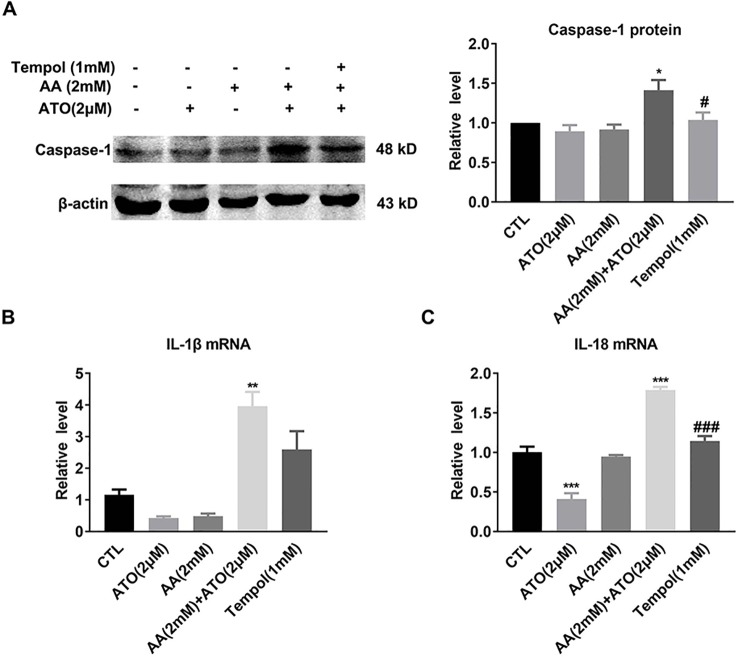
Antagonistic effects of tempol on the pro-pyroptotic action of ATO (2 μM)/AA (2 mM) combination in SW620 cells. (A) Tempol (1 mM) abolishes the elevation of caspase-1 protein level induced by ATO (2 μM)/AA (2 mM) combination treatment. The data are represented as mean ± SEM (n = 5). *P < 0.05, vs. Ctl; #
P < 0.05 vs. AA + ATO. (B, C) Tempol (1 mM) mitigated the increased mRNA levels of IL-1β and IL-18 induced by ATO/AA combination treatment. The data shown are mean ± SEM of three independent experiments. **P < 0.01, vs. Ctl. ***P < 0.001 vs. Ctl; ###
P < 0.001 vs. AA + ATO.